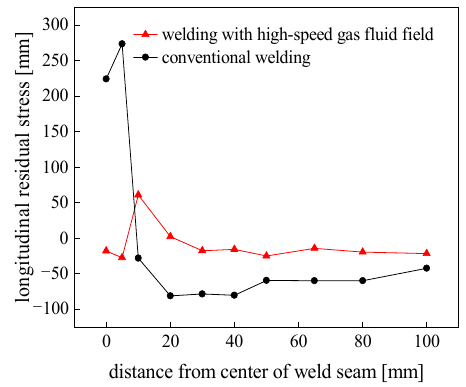
5 Figure 13. Strain gauge location arrangement for stress measurement. The residual stresses presented in the welded specimen were released by cutting the welded specimen along the mid-length section and then cutting both sides of the strain gauge along its long edge direction. The change in the elastic strain caused by the release of stress was indicated by a static strain device, and then the longitudinal residual stress was calculated using Hooke’s law. The longitudinal residual distribution of the welded specimens under different conditions can be seen in Figure 14. Note that with the appli-